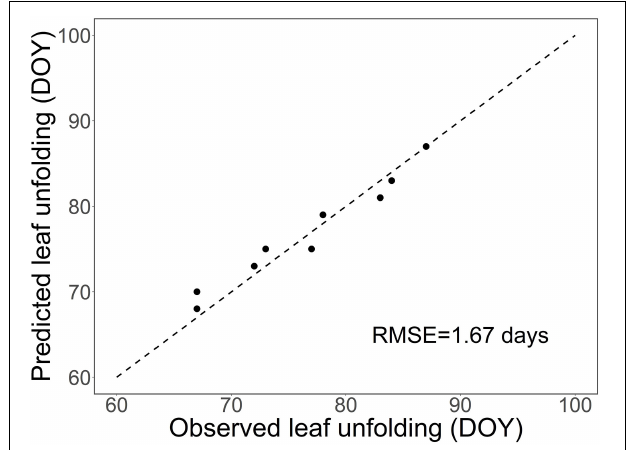
FIGURE 4 | Estimation of the upper threshold of the rest-breaking temperature range, T upp (refer to Figure 3A ) by fitting the overall model to the results of the nine temperature treatments of the whole-tree chamber (WTC) experiment. The graph shows the root mean square error (RMSE) of the leaf-out timing predicted by the overall model for the experiment as a function of the value of T upp used in the simulations. With each value of T upp , the calculations were started on t 0 = November 15, because the use of that date minimized the RMSE among the dates tested (refer to the section “Results” in the text). With the lowest value of T upp tested (+6 ◦ C), the model failed to predict any leaf-out for three of the nine temperature treatments in the experiment because of insufficient chilling. This is why no RMSE is given for T upp = +6 ◦ C.